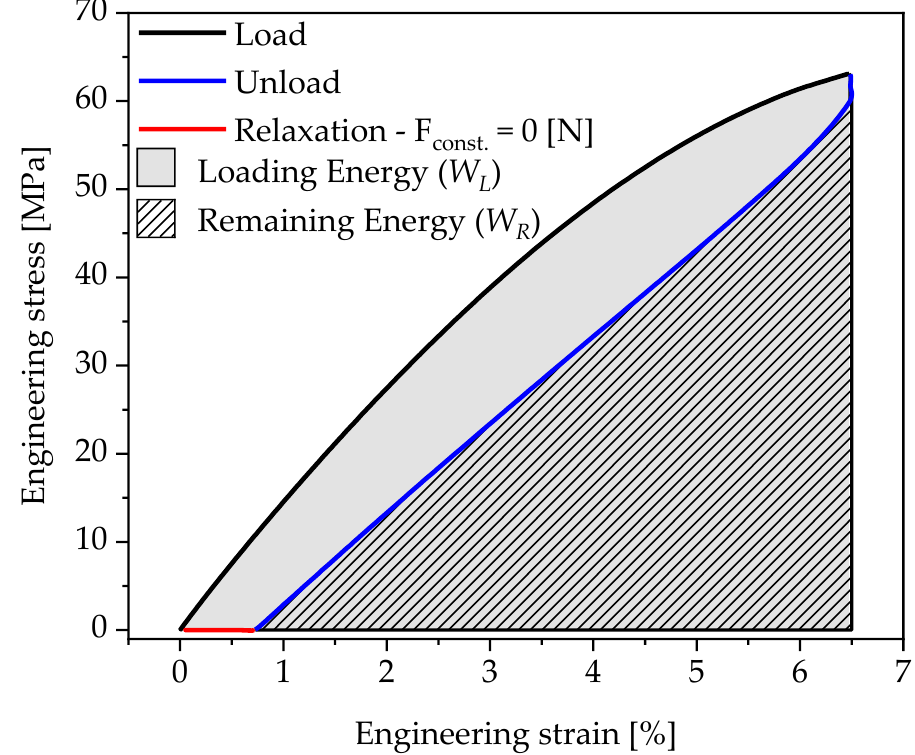
Figure 4. Stress–strain curve of a test cycle with loading, unloading, and relaxation phase. Figure 4. Stress – strain curve of a test cycle with loading, unloading, and relaxation phase. By integrating the engineering stress σ E over the engineering strain ε E , the loading energy density of a loading procedure is determined: